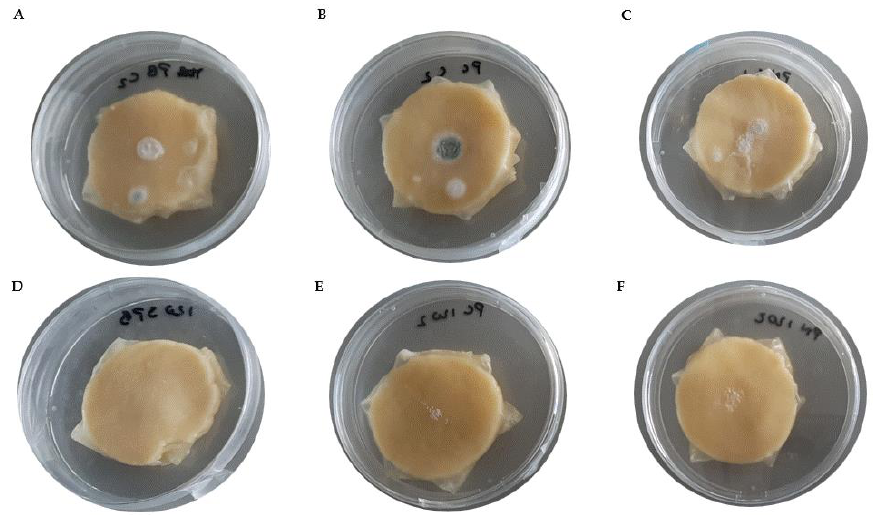
Figure 6. Growth on day 15 of P. brevicompactum ( A , D ), P. commune ( B , E ), and P. nordicum ( C , F ) by inoculation with spore solution on the surface of cheese wrapped in whey – gelatin control films ( A – C ) and whey – gelatin films containing L. brevis SJC120 ( D – F ).